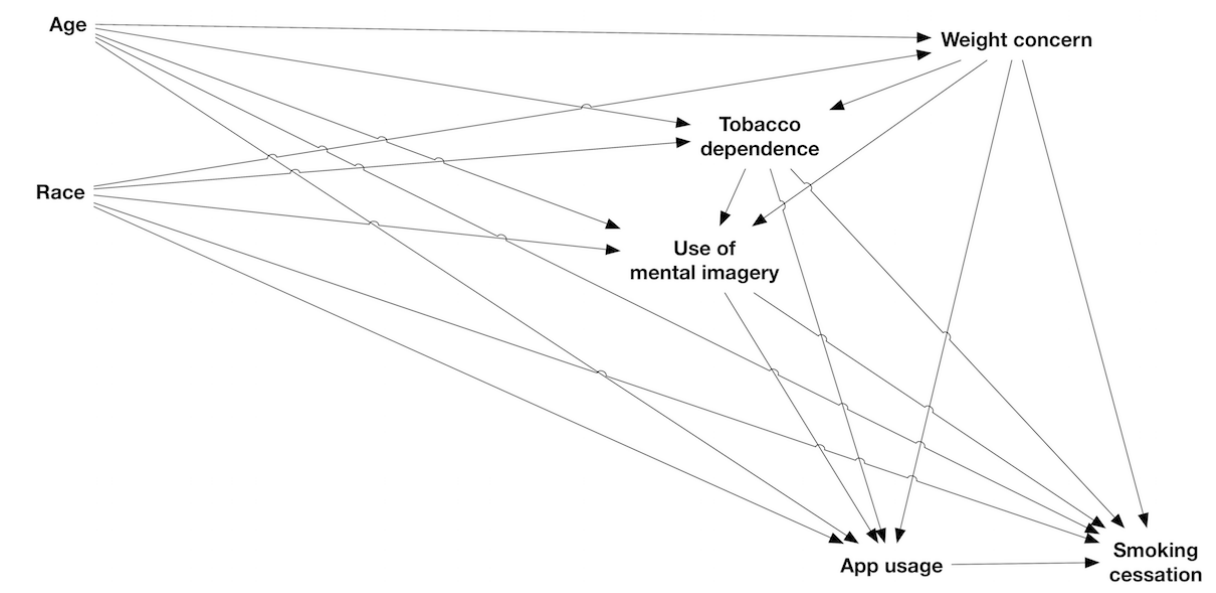
Figure 1. Directed acyclic graph showing hypothesized relationships among principal exposure, confounder and outcome variables (see text for details of which variables filled these roles in each analysis). App usage and smoking cessation each consist of several measures and are displayed here in a simplified